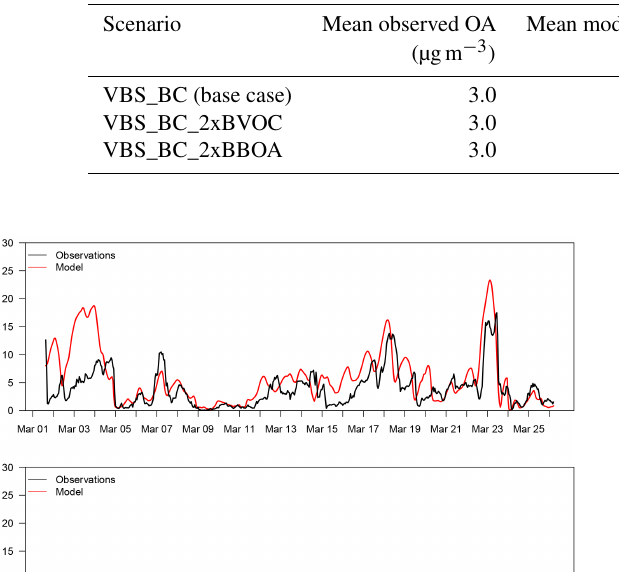
Table 5. Statistical analysis of OA for VBS_BC, VBS_BC_2xBVOC and VBS_BC_2xBBOA scenarios for the 11 AMS sites for February– March 2009.